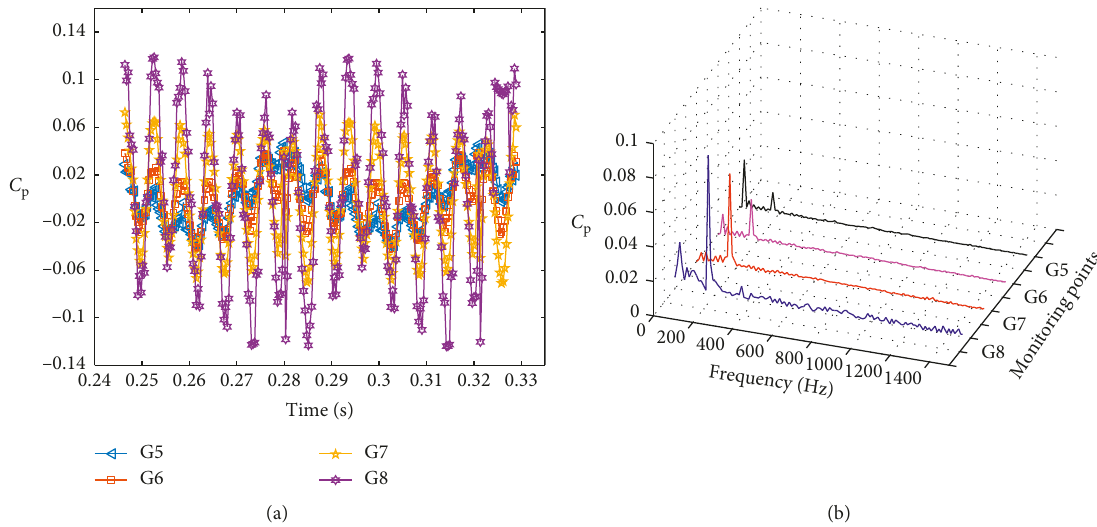
Figure 8: Pressure pulsation in axial flow pump under design flow rate. (a) Time domain. (b) Frequency